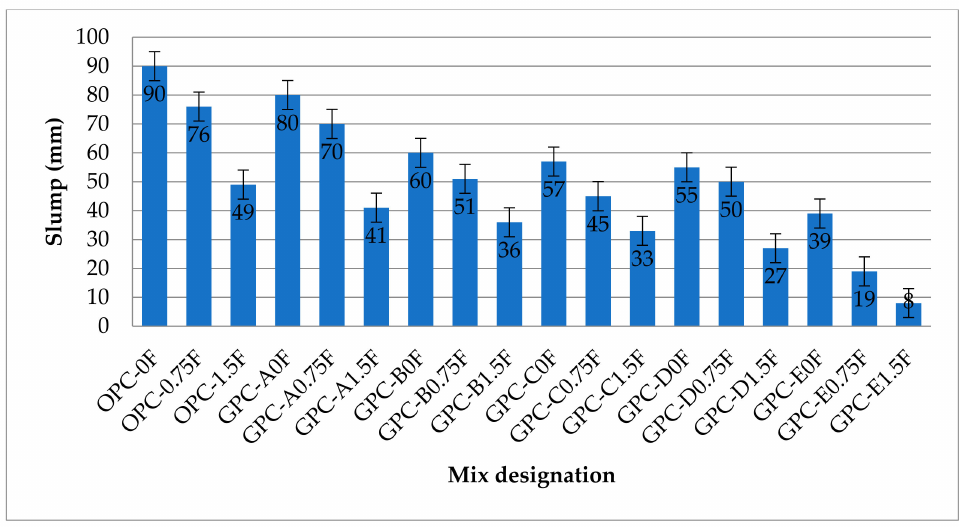
Figure 4. The slump values of GPC and OPC